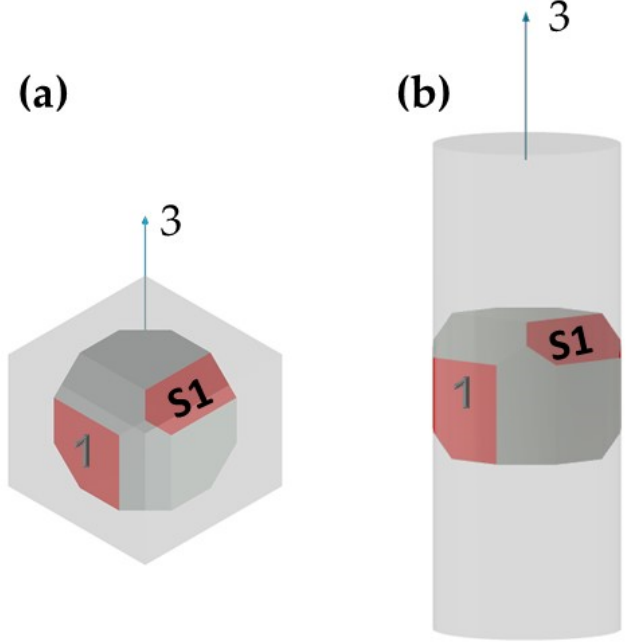
Figure 10. Illustration of the polygon DED ( a ) and wrought ( b ) samples. The red facets 1 and S1 were analyzed by SEM-EBSD.